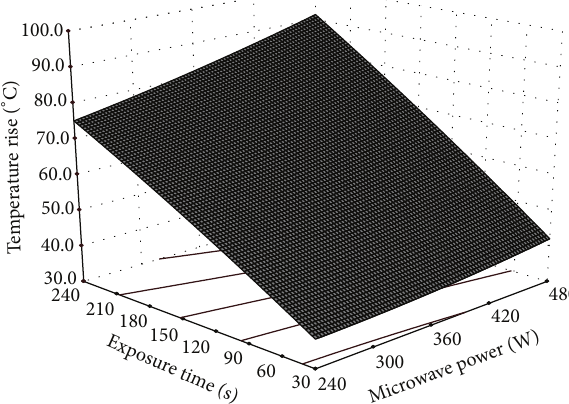
Figure 2: Effect of microwave power and exposure time on color change of cashew nuts. Figure 3: Effect of microwave power and exposure time on temper- ature rise of cashew